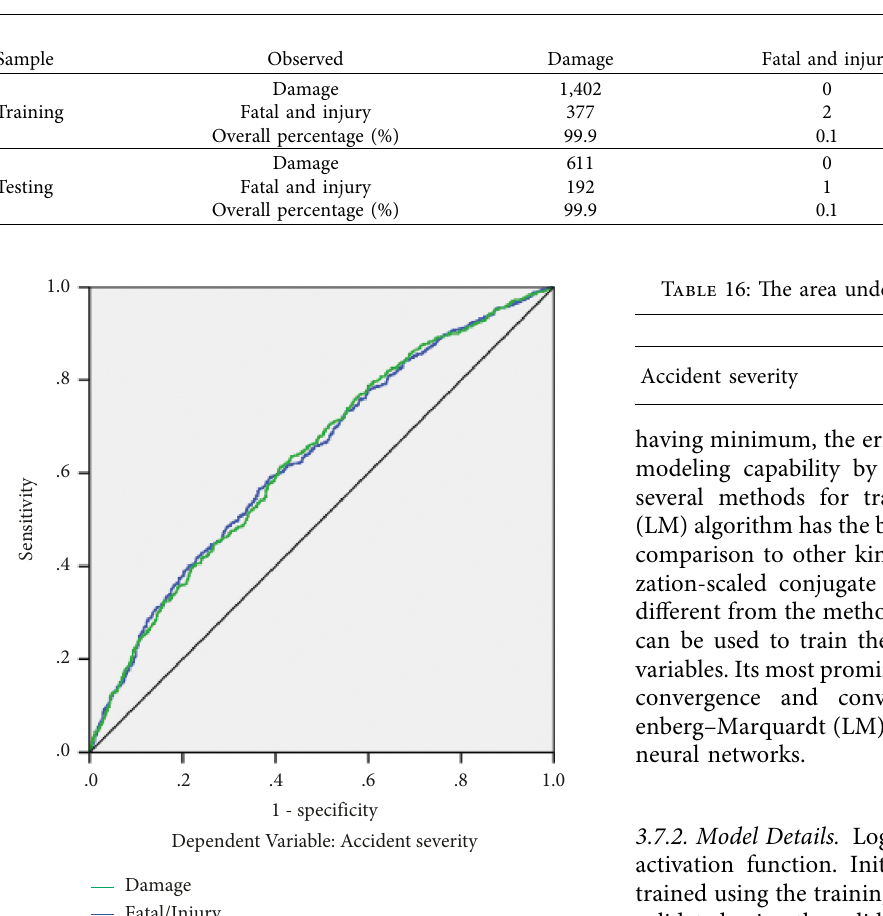
Figure 11: Independent variable importance chart in the MLPNN Table 15: Classification in the RBFNN model.